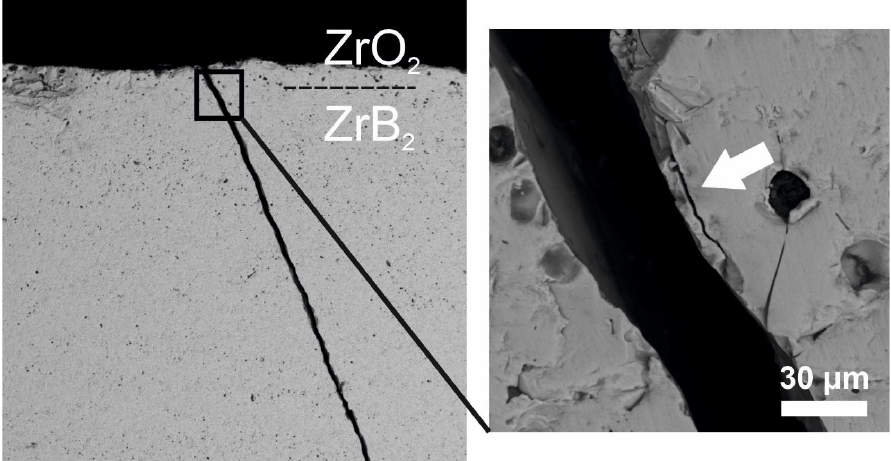
Figure 6. Crack propagation behavior in the ZrO 2 layer on the ZrB 2 –SiC substrate.